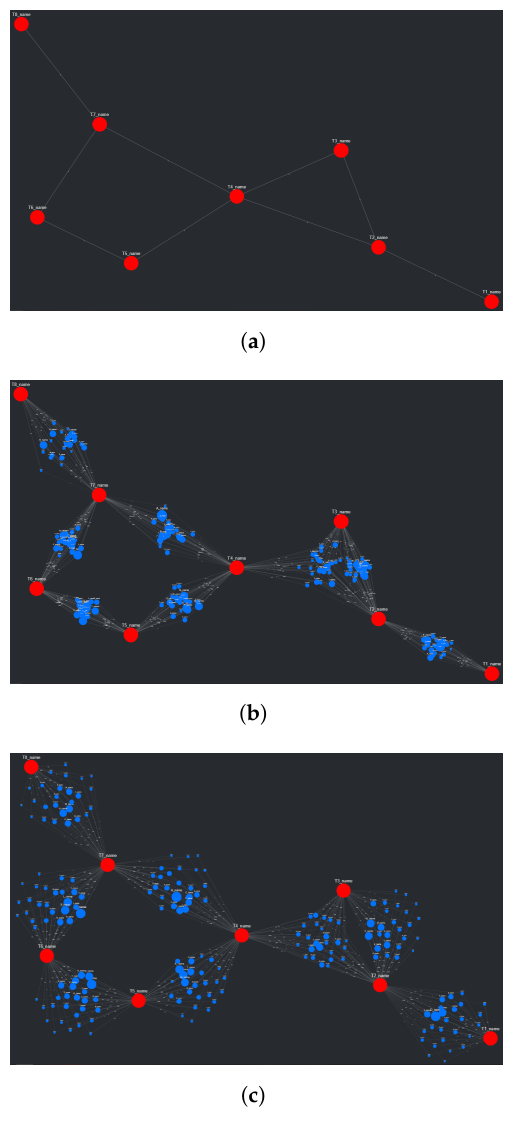
Figure 5. The adjusted spring layout method, broken down into three logical steps. The data shown are placeholder data used in CompositeView. ( a ) Initial target nodes are simulated and positions are fixed. ( b ) Artificial edges are removed and source nodes are filled in around the shared target node centroids. ( c ) Source nodes are simulated with edge